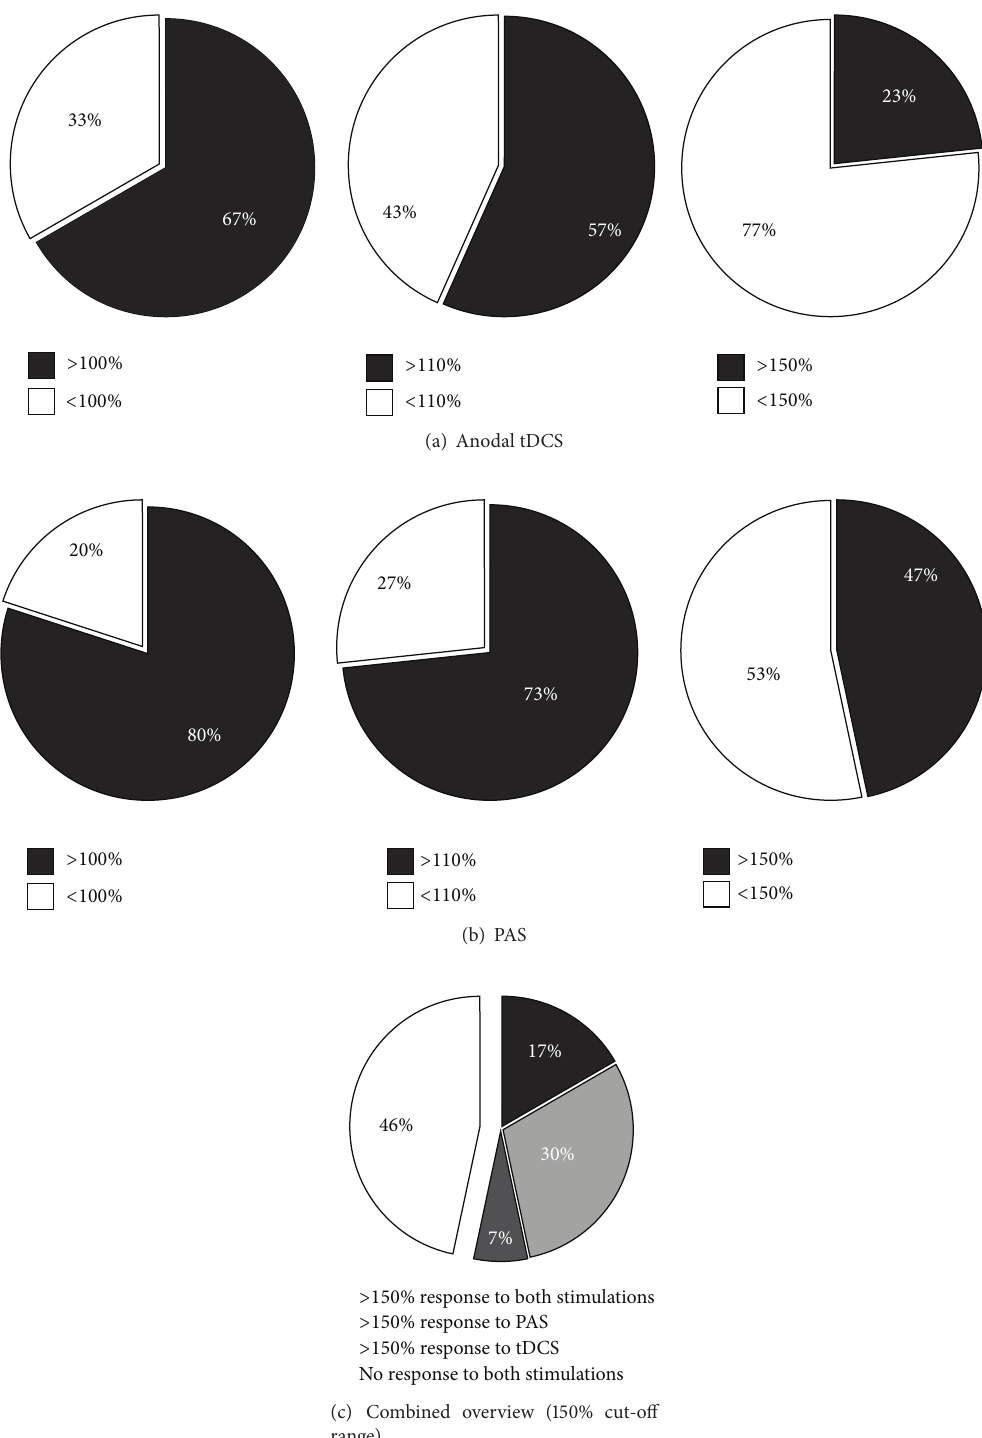
Figure 3: Individual response patterns of all subjects for (a) anodal tDCS and (b) PAS separated according to the defined cut-off ranges of > 100%, > 110%, and > 150% relative to baseline MEP values (set as 100%). Responders (R) are depicted with grey coloured fields and nonresponders (NR) with white fields. (c) Grouped presentation of responders to both stimulation types (17%, dark grey), to PAS only (33%, light grey), or to anodal tDCS only (7%, intermediate grey) and nonresponders (46%, white) for the > 150% cut-off range relative to baseline MEP values (set as